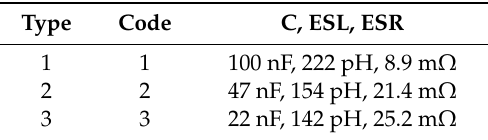
Table 1. Decoupling capacitors and their code.